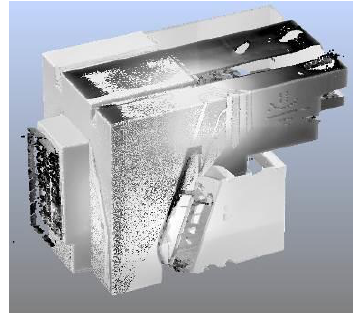
Figure 2. Example of scan data under FARO